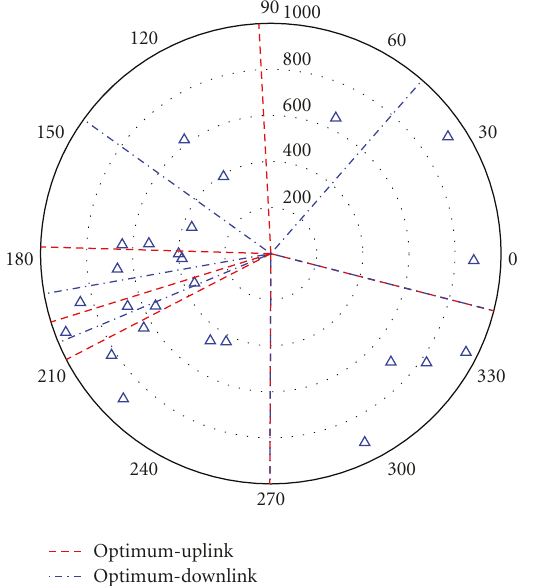
Figure 7: Sector boundaries for the uplink of a CDMA system with nonuniform user distribution. Number of users, M = 25; process- ing gain, N = 16; number of sectors, K = 6.